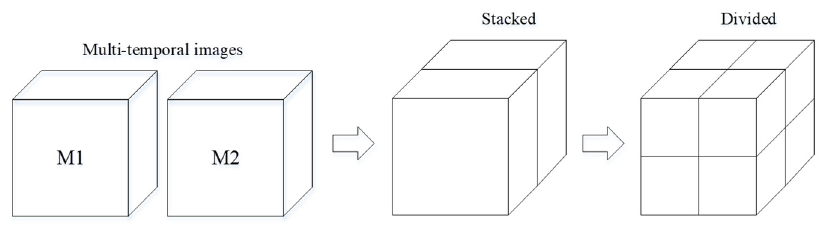
Figure 1. The illustration of the Multitemporal images stacking and